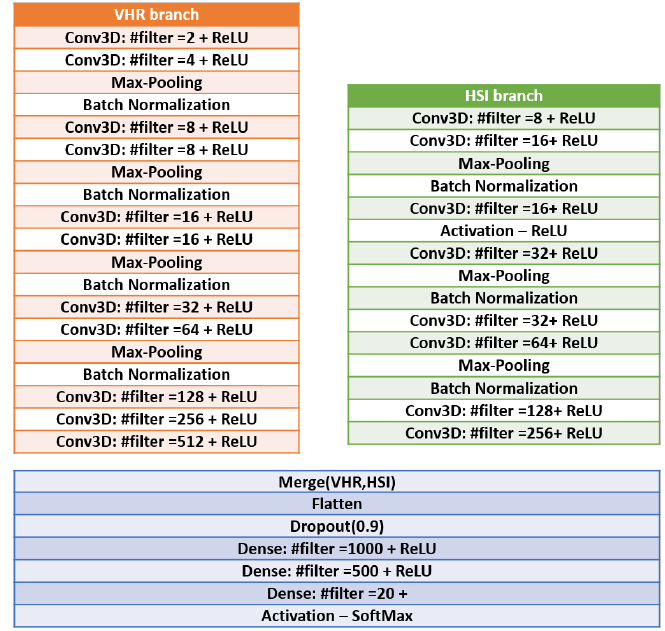
Figure 2. Parameters of the proposed multi-modal classification network. Conv3D corresponds to a 3D convolution, with the provided number of filters, followed by a ReLU non-linear activation. Dense indicates a fully connected layer with the provided number of filters, followed by a ReLU activation